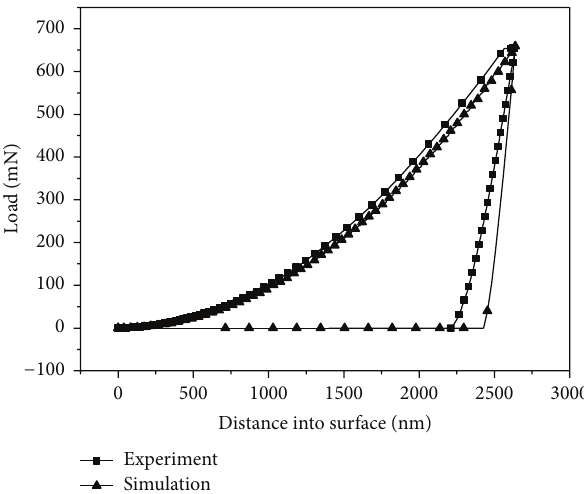
Figure 13: Experiment and simulation of load-depth curves.